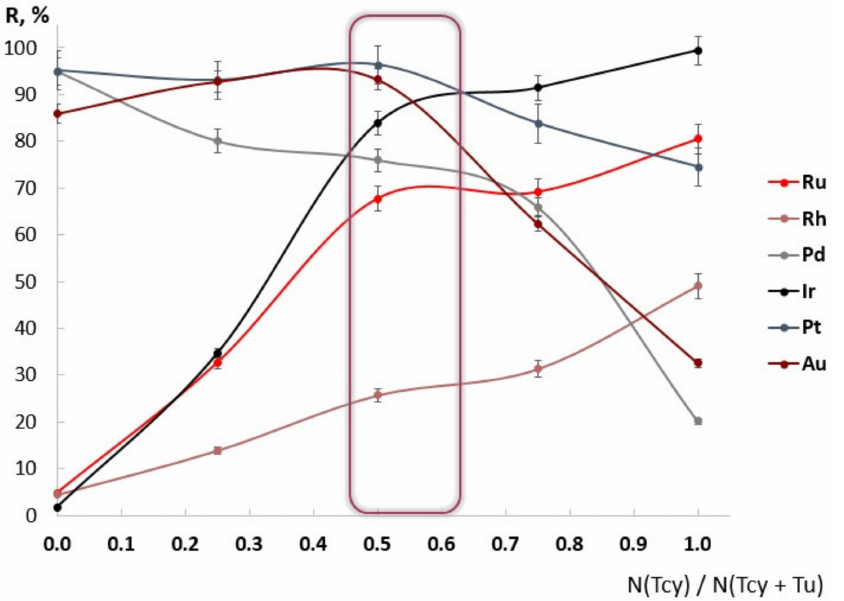
Figure 4. The isomolar series of desorption using thiourea–thiocyanate mixture in 0.2 M HCl ( n = 3, p = 0.95). The sum of concentrations of thiourea and thiocyanate was equal to 0.5 M. Sorption from SOMB-6 solution.